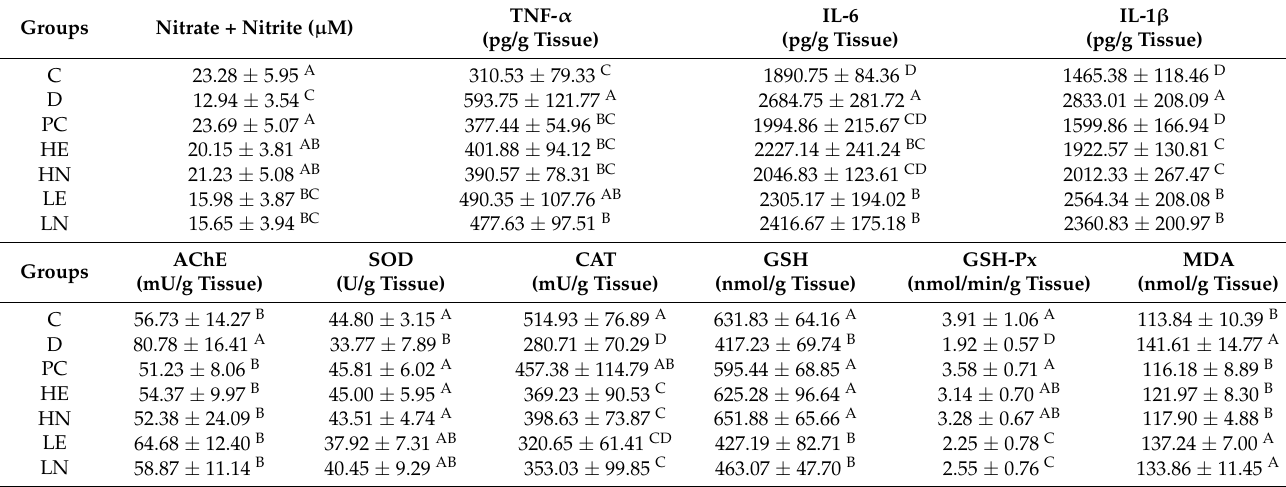
Table 4. Effect of the administration of black garlic extract and nanoemulsion on nitric oxide concentration in plasma and contents of tumor necrosis factor- α (TNF- α ), interleukin-6 (IL-6) and interleukin-1 β (IL-1 β ) as well as activities of acetylcholinesterase (AChE), superoxide dismutase (SOD), catalase (CAT), glutathione (GSH), glutathione peroxidase (GSH- Px) and malondialdehyde (MDA) concentrations in hippocampus in DOCA-salt-induced hypertension and its associated mild cognitive impairment in